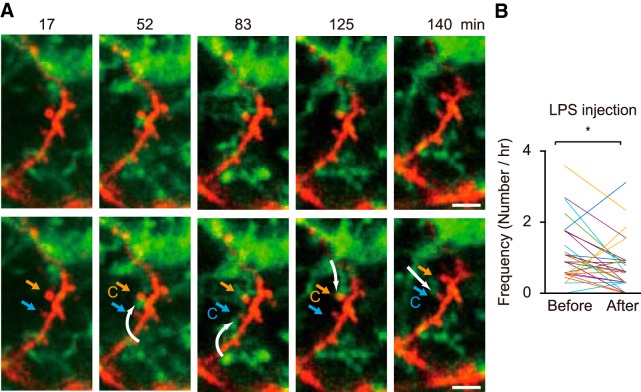
Specific activated microglial processes contact different spines, while a single spine may be contacted by different activated microglia. A, As in Figure 2 for physiologic microglia, the processes of the same specific activated microglia contact two different spines (orange arrow spine at 52 min, blue arrow spine at 83 min). The same two spines are later contacted by processes originating from a different microglia. B, The mean frequency of contacts between microglial processes and spines in mice with an acute injection of LPS. LPS decreases the contact frequency from 1.17 ± 0.16/h under control to 0.76 ± 0.13/h after LPS injection (n = 31 spines from four mice, p = 0.0132, paired t test). *p < 0.05.